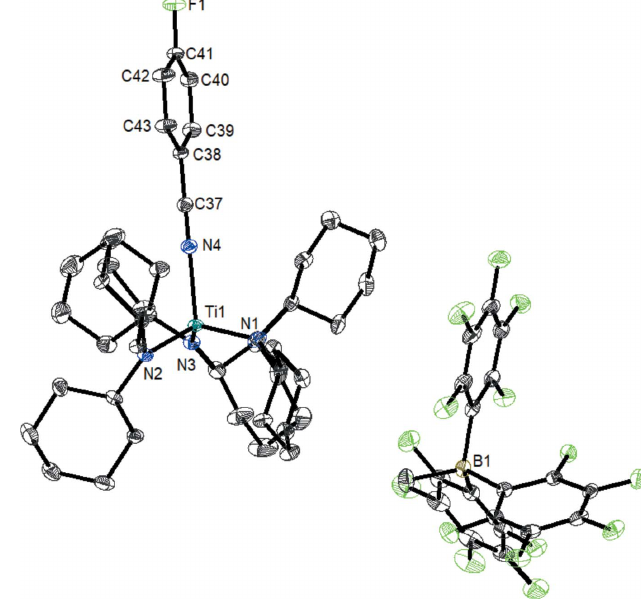
Figure 2 Molecular structure of compound ( 2 ). Displacement ellipsoids corre- spond to the 50% probability level. For clarity, only the major components of disordered parts are shown, and H atoms as well as solvent molecules have been omitted.